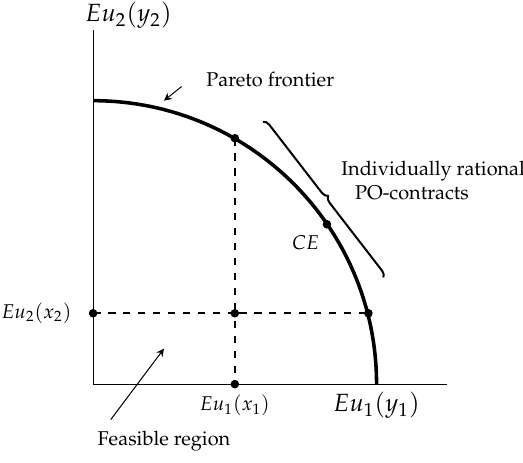
Figure 1. The Pareto frontier for N =